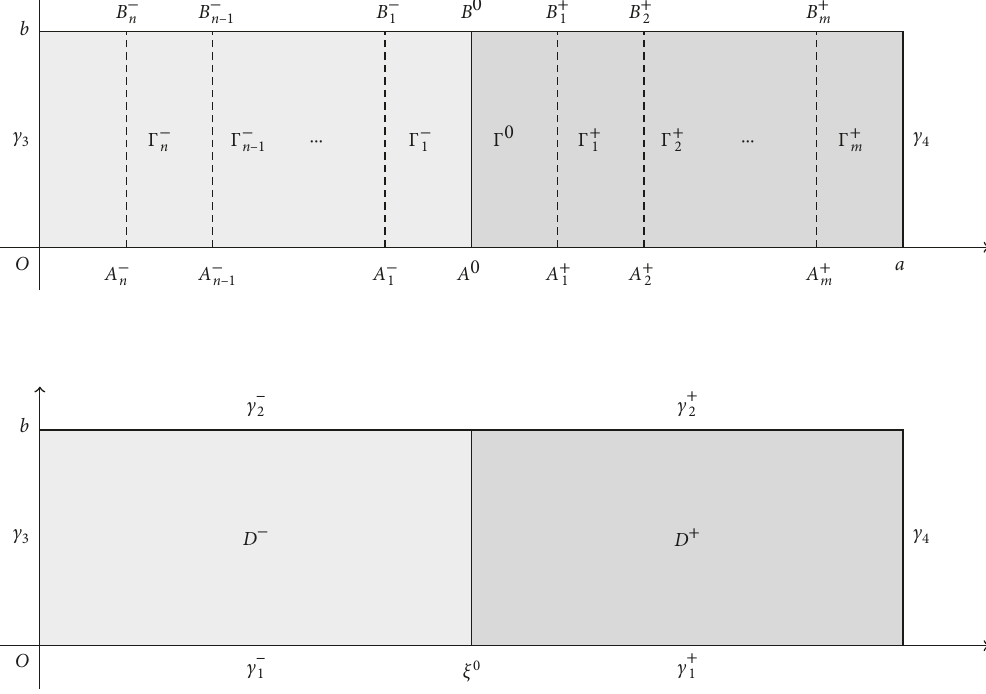
Figure 2: Domain for contact problem for equation with variable coefficients D � D ∪ c